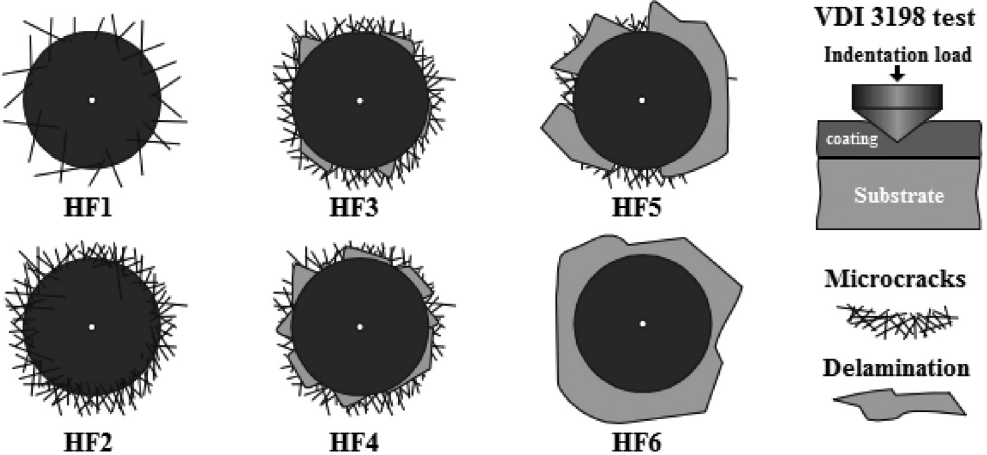
Fig. 7: Principle of the VDI 3198 indentation test